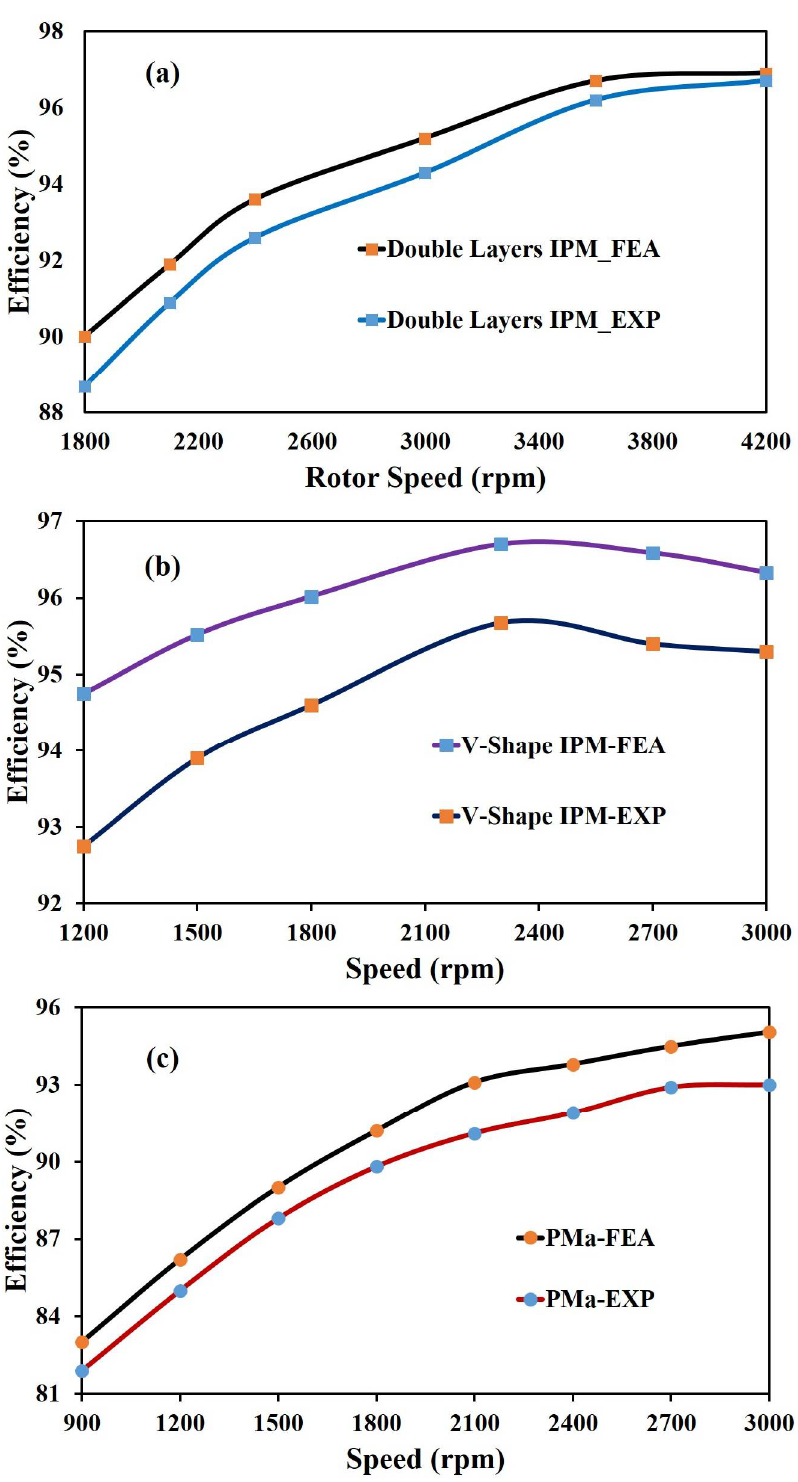
Figure 24. Efficiency vs speed curve at rated condition: ( a ) double layers IPMSM, ( b ) V-Shaped IPMSM, and ( c ) PMa-SynRM.